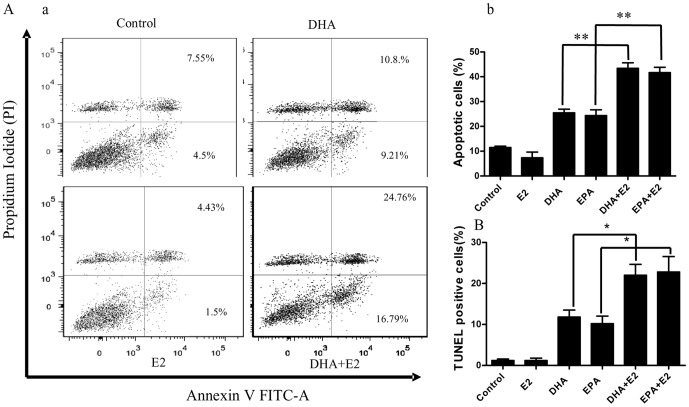
E2 increases the apoptosis of n-3 PUFA-treated BCa cells.
A. E2 increases DHA-induced apoptosis in MCF7 cells. After 12 -hour n-3 PUFA treatment, E2 was applied, and cells were cultured for 72 hours. Apoptosis was assayed with flow cytometry after staining with PI and Annexin V (see Methods). a, Apoptosis was determined after treating MCF-7 cells with E2, DHA (90 µM), or DHA+E2. Flow cytometry profile represents Annexin V staining in x axis and PI in y axis. b, Quantitated data include PI−/Annexin V+ (early indicator of apoptosis) and PI+/Annexin V+ (later stage apoptosis indicator) cells (n = 3). B, TUNEL assay for cell apoptosis. TUNEL-positive cells were stained in nuclei (see s-Figure 1 B). Percentages of TUNEL-positive cells were counted. C, E2 decreased Bcl2 expression in MCF-7 cells that were treated with DHA or EPA (90 µM) (n = 3). The mRNA level of Bcl2 was measured with Q-PCR. * p<0.05. ** P<0.001.